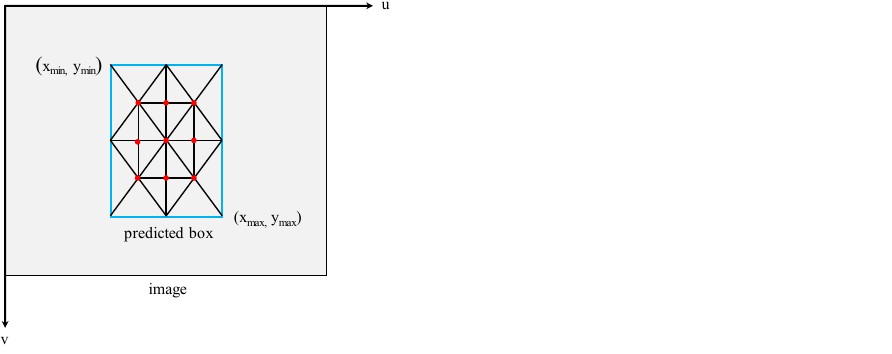
Figure 6. The positional relationship of the 9 points used for distance estimation as indicated by the red dots.